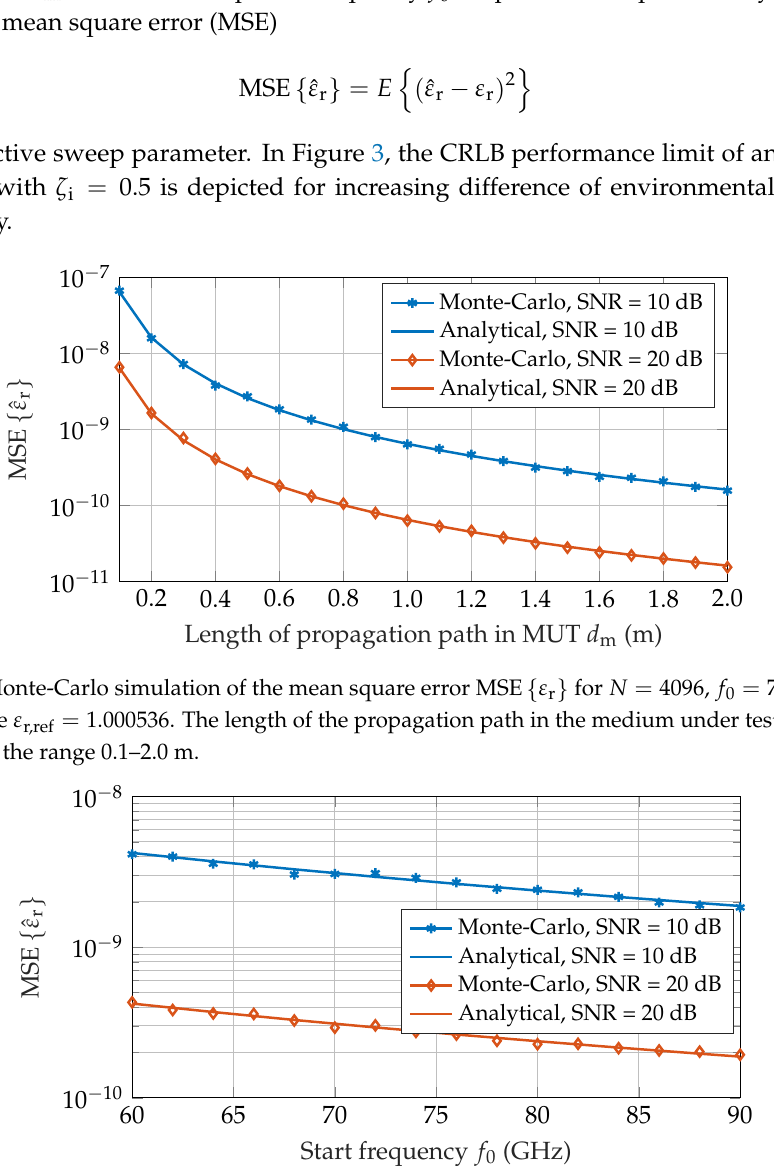
Figure 2. Monte-Carlo simulation of the mean square error MSE { ε r } for N = 4096, d m = 0.5m and air reference ε r,ref = 1.000536. The start frequency of the frequency modulated continuous wave (FMCW) chirp signal f 0 is varied in the range 60–90